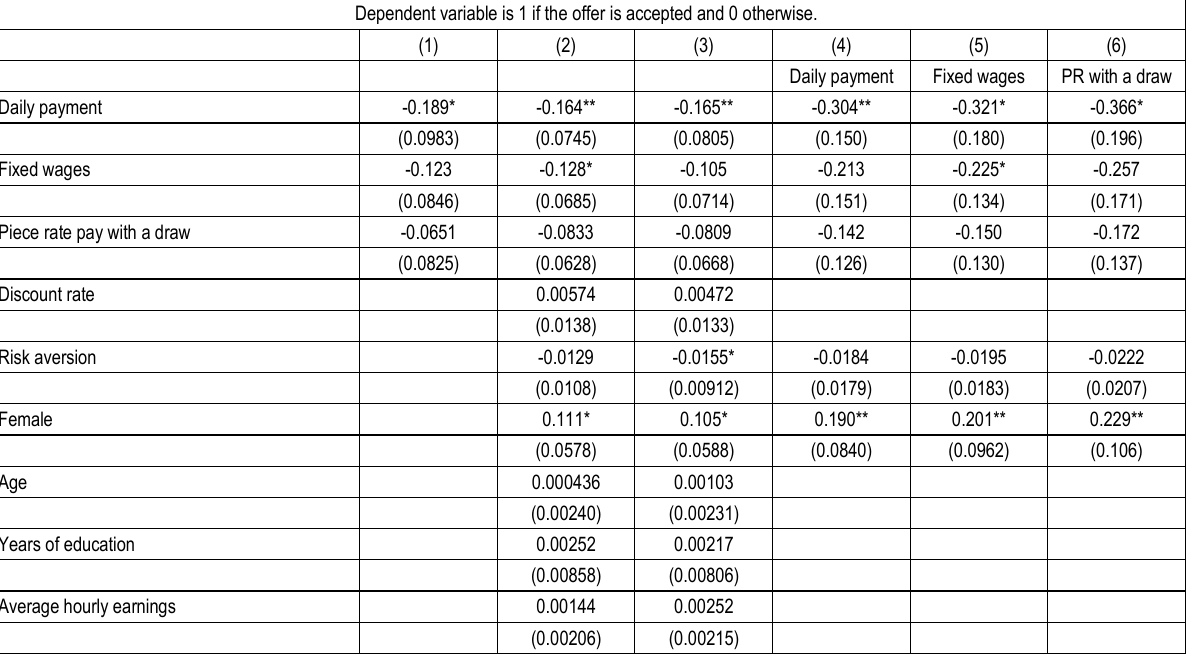
Table 3. Accepting a job offer: marginal effects (logit